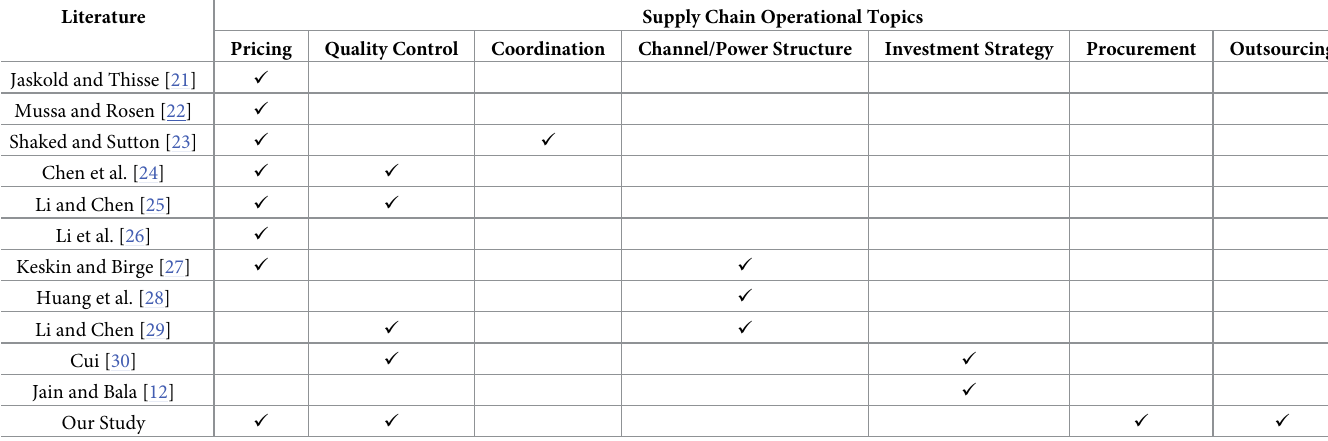
Table 2. Summary of the related literature regarding product quality differentiation in competition.